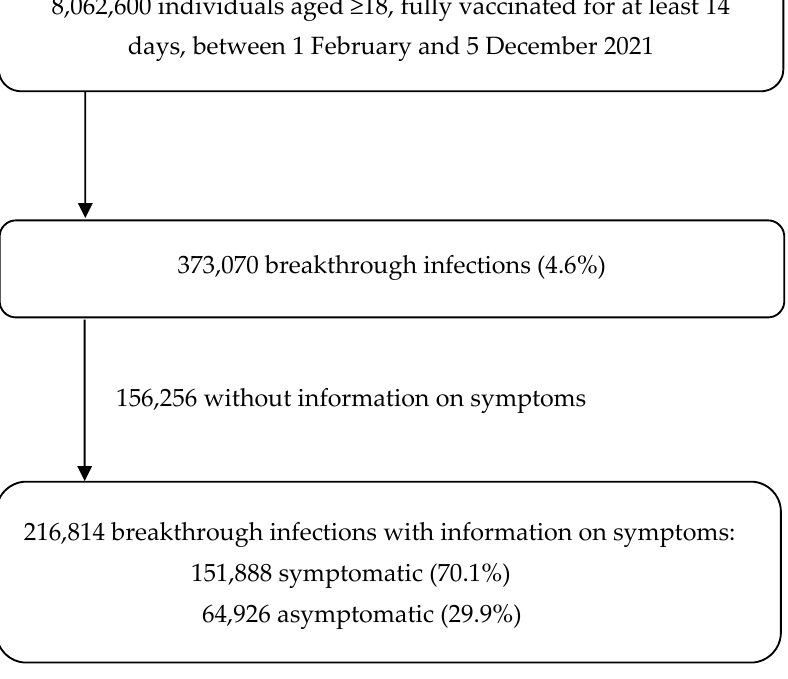
Figure 1. Flow chart of individuals fully vaccinated for at least 14 days on 5 December 2021 in Belgium, with the occurrence of (symptomatic) breakthrough COVID-19 infections. Breakthrough infection = laboratory confirmed COVID-19 infection after at least 14 days after the last vaccine dose; symptomatic breakthrough infection = laboratory confirmed COVID-19 infection after at least 14 days after the last vaccine dose with compatible COVID-19 symptoms.